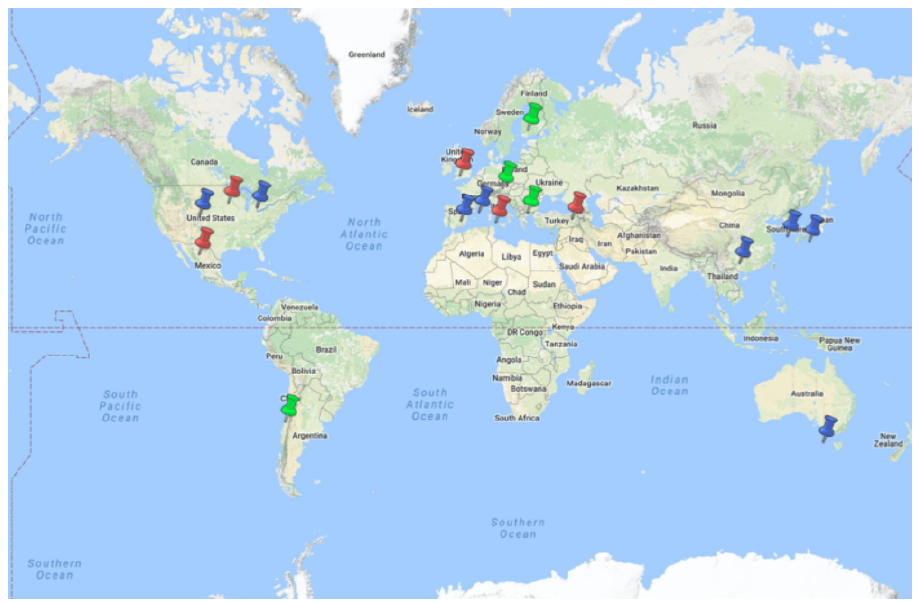
Figure 15: A map showing the 17 current underground facilities that can house dark matter experiments, as well as other scientific payloads that benefit from a location below the Earth’s